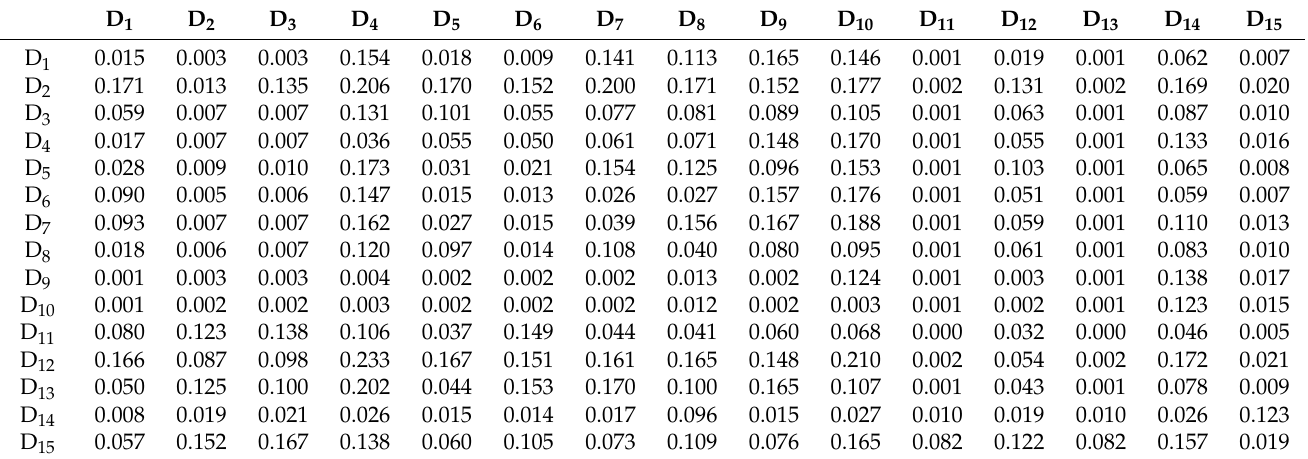
Table 7. Lean Green Driver Indicator Composite Impact